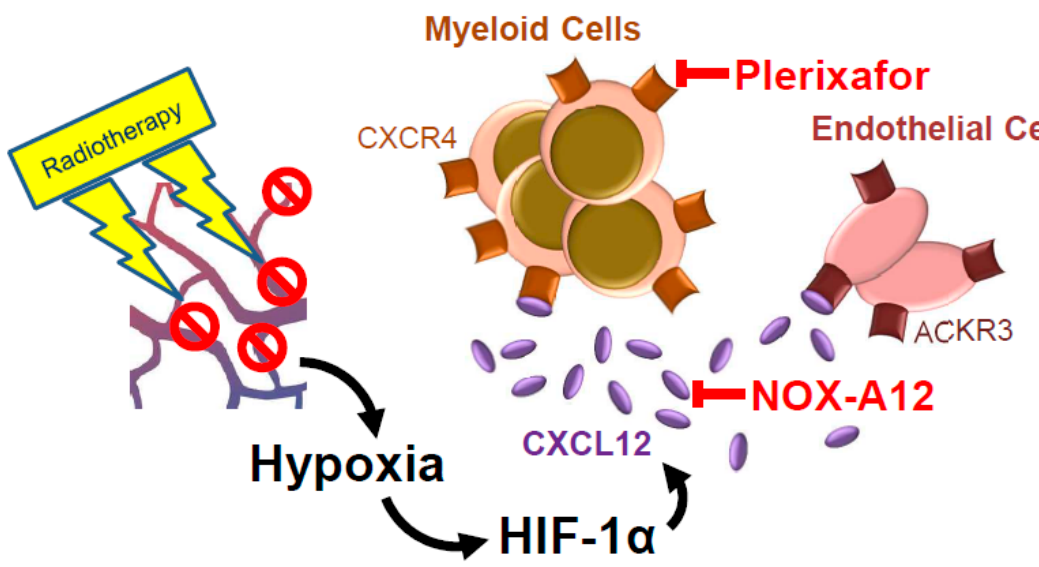
Figure 2. Radiotherapy increases hypoxia in glioblastoma by damaging the tumor vasculature. This leads to upregulation of CXCL12 via HIF-1 α (hypoxia-induced factor-1 α ). Plerixafor (AMD3100) is representative of a number of different types of CXCR4 inhibitors. NOX-A12 binds to and inhibits CXCL12